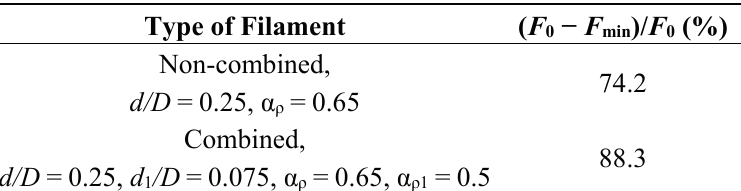
Table 3 . Blunt cylinder, M = 3.